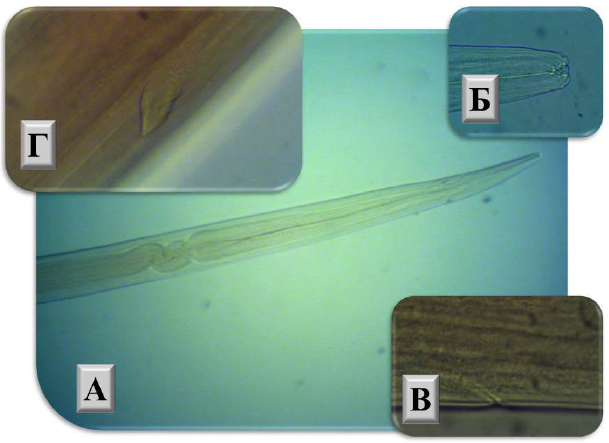
Fig. 2. Main end of H. contortus (× 100; × 400) Differential features for males of this species are the presence of a wide genital bursa with two spicules and a handle between them (Fig. 3 A.), and for females – a section of the vulva (Fig. 3 B.) with a tongue-shaped cuticular